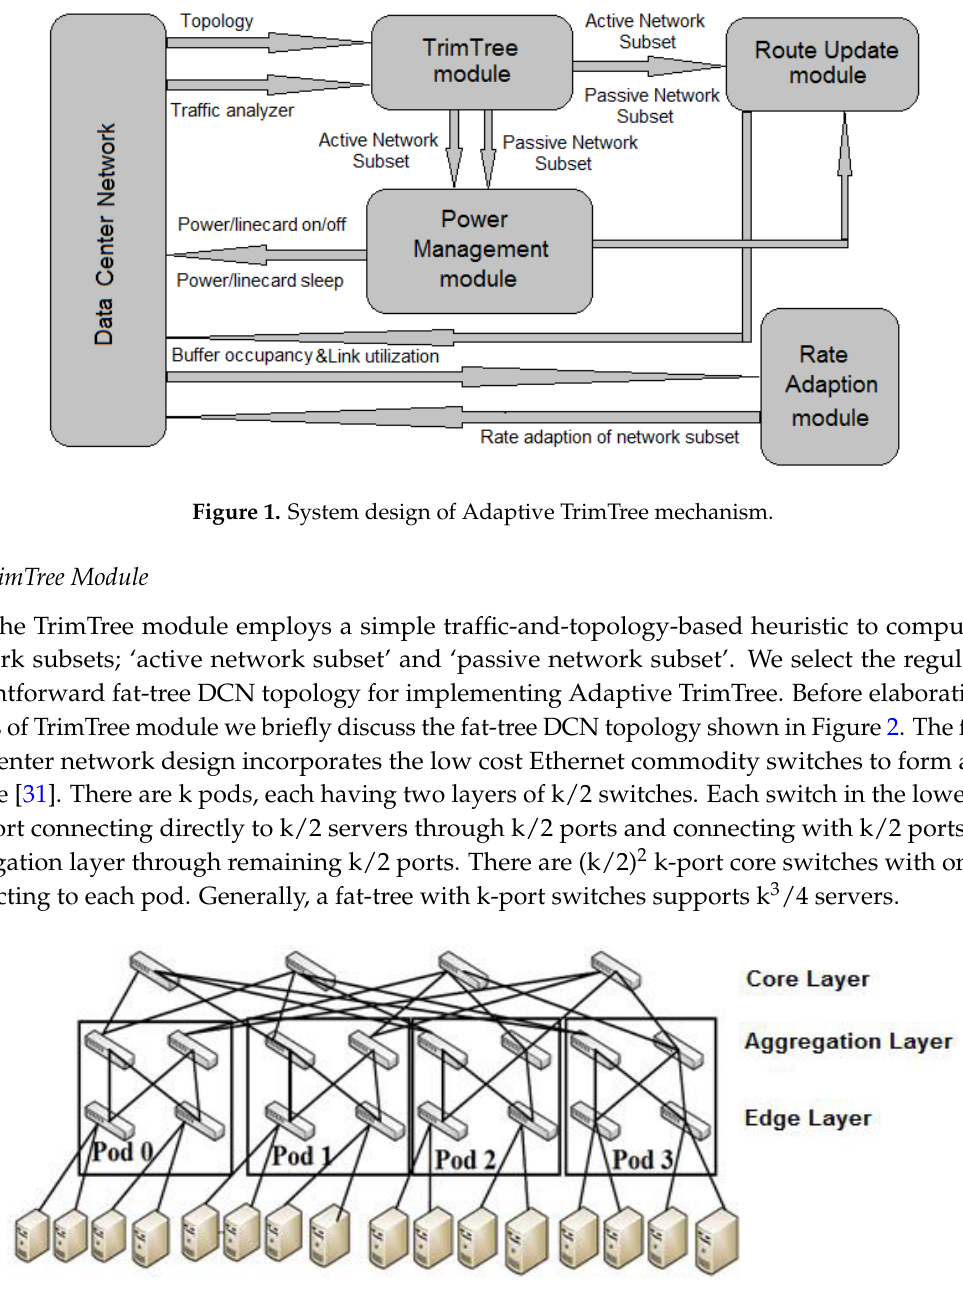
Figure 2. Fat-tree topology of Data Center Network.